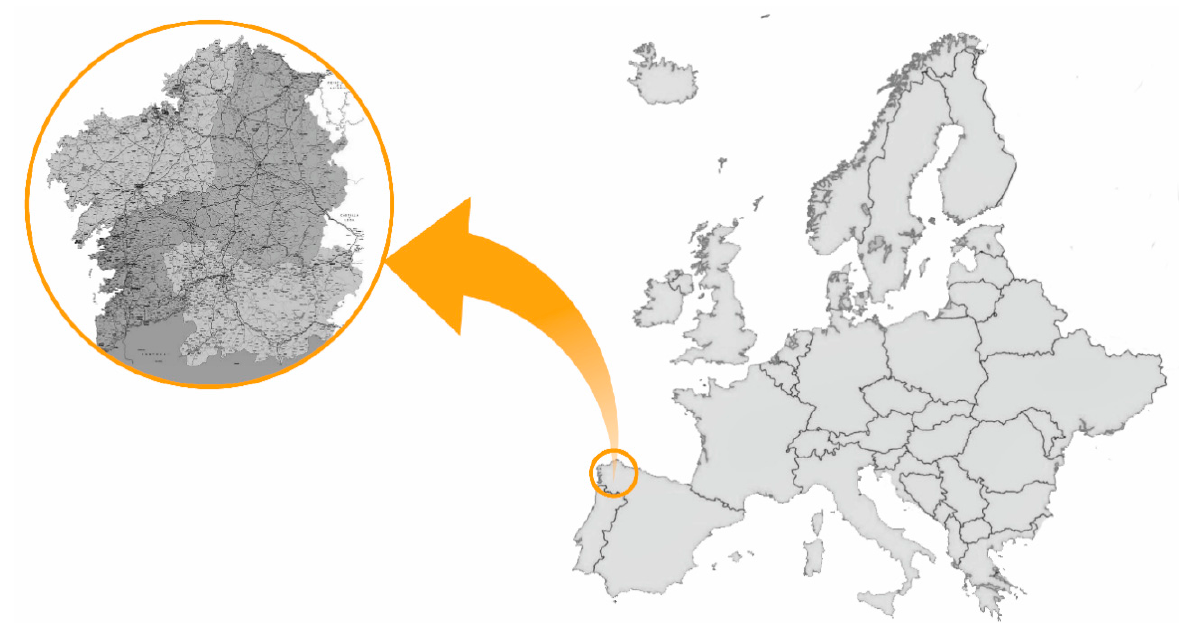
Figure 1. Location of Galicia.